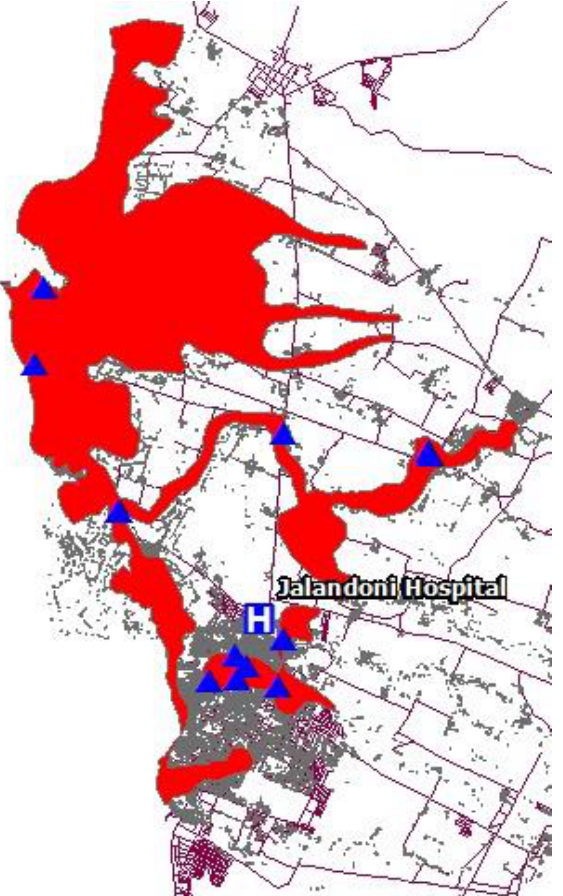
Figure 9. Service area analyses output. Brown areas need 80kph speed to reach the target 6-min response